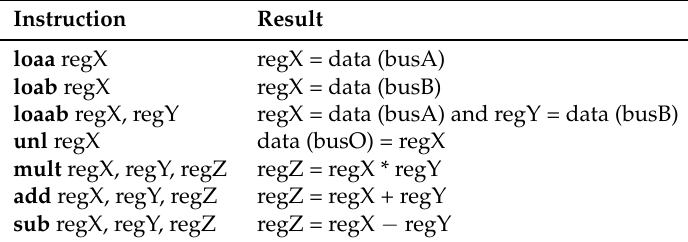
Table 1. Basic instruction set of developed MPA